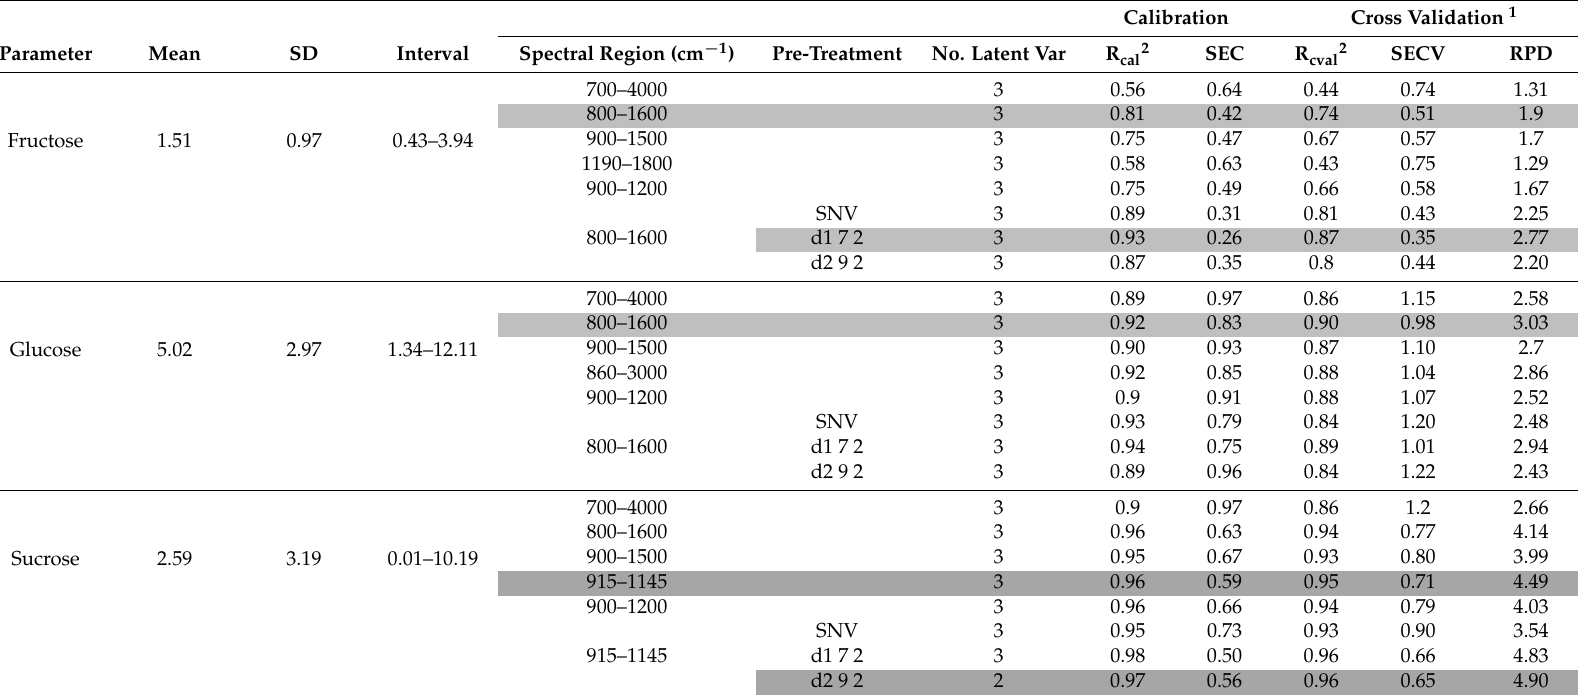
Table 3. FT-MIR prediction of sugars in plum juice obtained from the fruit of three cultivars during their development—descriptive statistics and PLS (partial least squares) calibration models performance for selecting optimal spectral region and